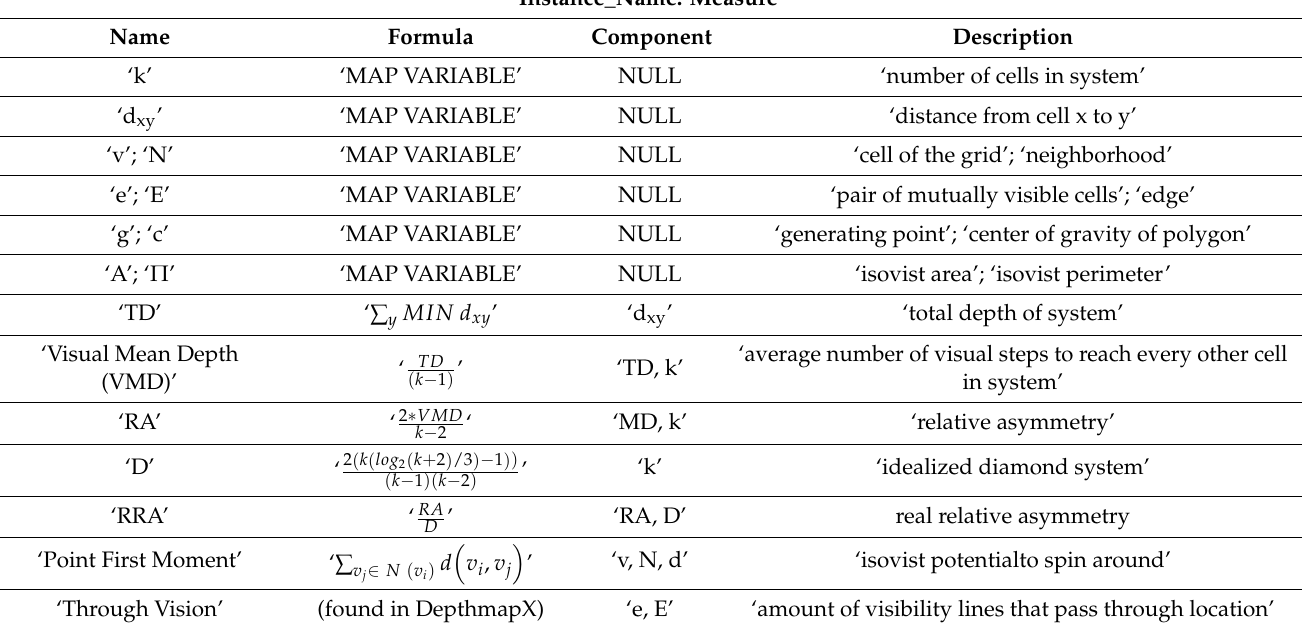
Table 4. VGA measures for basic meta-pattern values identification (measures are taken from Reference [9]).